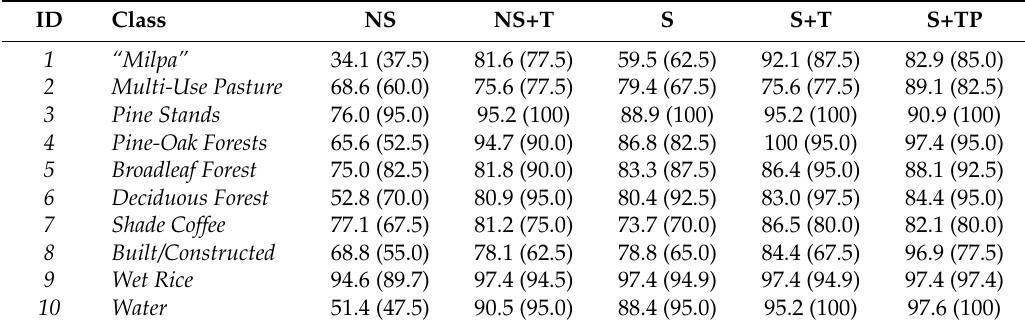
Table 6. Changes in Per-Class Sensitivity and Specificity with Multi-Seasonal Spectral Variables, Topographical Information, and Precipitation